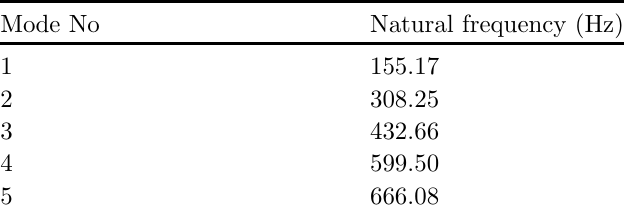
Table 4. Modal analysis results obtained from FEA. Mode